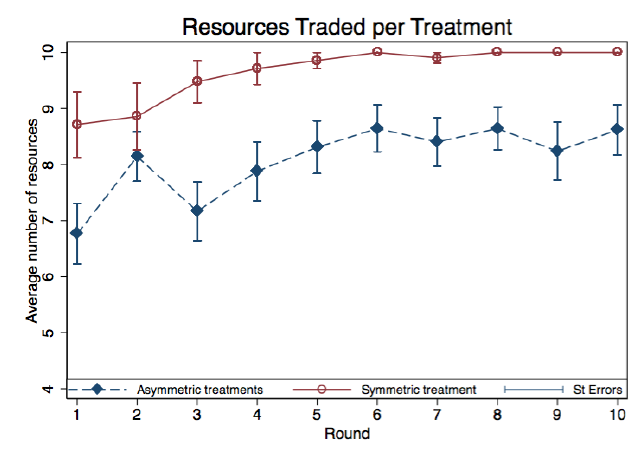
Figure A1. Mean actual number of resources traded per round in the symmetric and asymmetric price treatments, with standard errors. The buyer and seller treatments are merged into one asymmetric treatment. The figure shows that trade in the symmetric treatment quickly converges to full trade, while the number of resources traded in the asymmetric treatments is